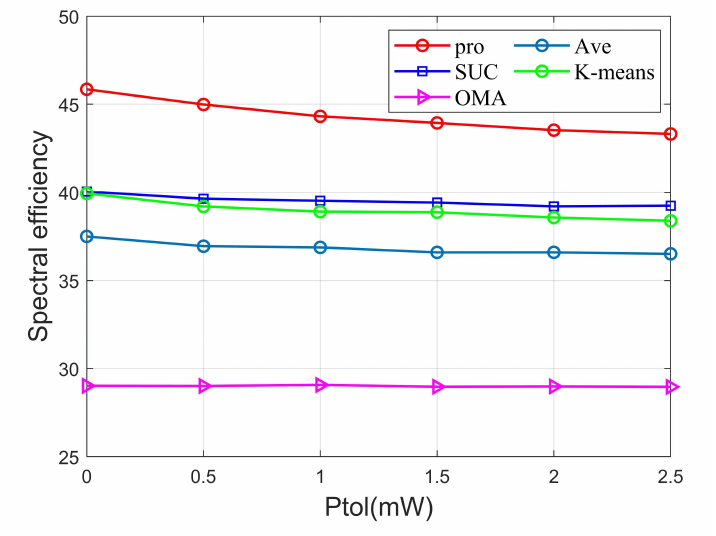
Figure 7. SE versus P tol of different